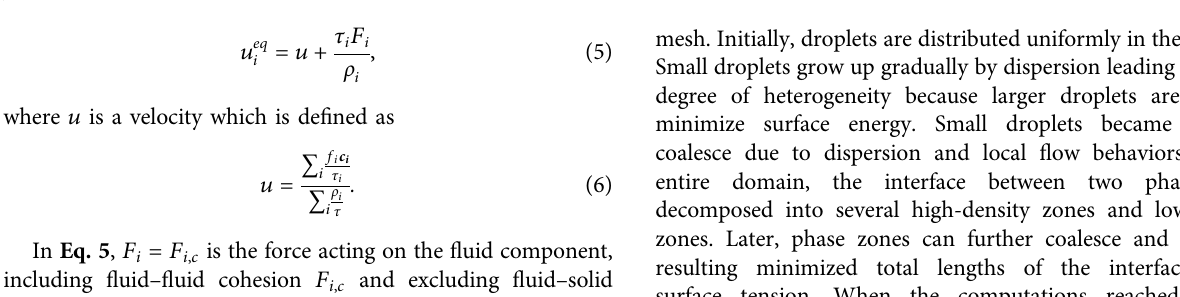
FIGURE2| Density fi eldsunder isothermal conditionsforphaseseparationprocedureswith ρ * (cid:2) 1.2and τ * (cid:2) 1usingthe interactive strengths withG (cid:2) − 30 atfour times: (A) 100 ts, (B) 200 ts, (C) 300 ts, and (D) 1800